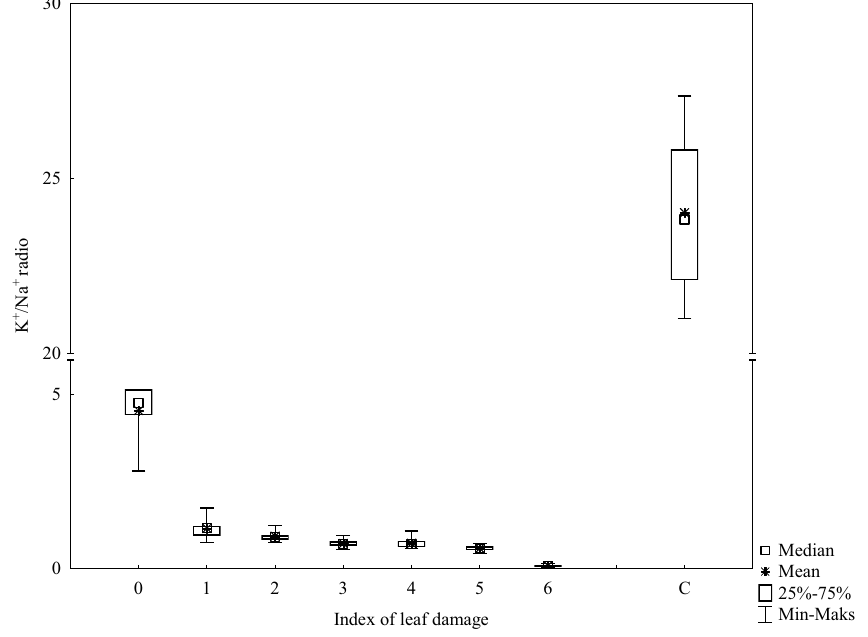
Figure 4. K + /Na + ratio in different foliage samples. C = park trees (control, n = 5), 0–6 = roadside trees (n = 10 per leaf damage severity).